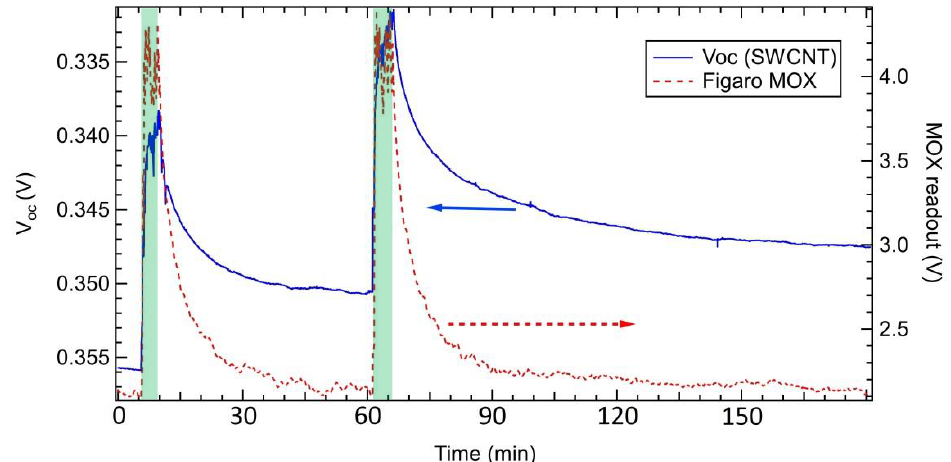
Figure 4. Sequence of exposures to NH 3 in air tracked by the V OC read-out on the SWCNT / Si PV cell (left axis, thick line) compared to the read-out of the Figaro MOX (right axis, dashed line). Data from the SWCNT PV cell were collected under white light illumination. The left axis has been reversed to allow for comparison with data from the Figaro MOX. The shaded areas represent the exposure phase.